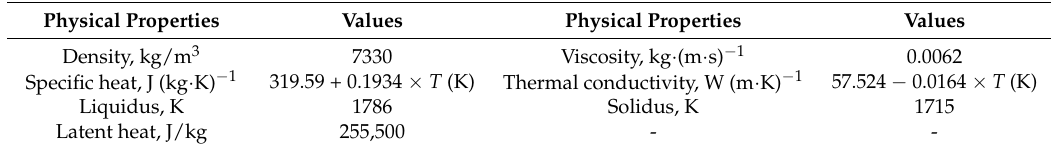
Table 2. Physical properties of steel Q345.